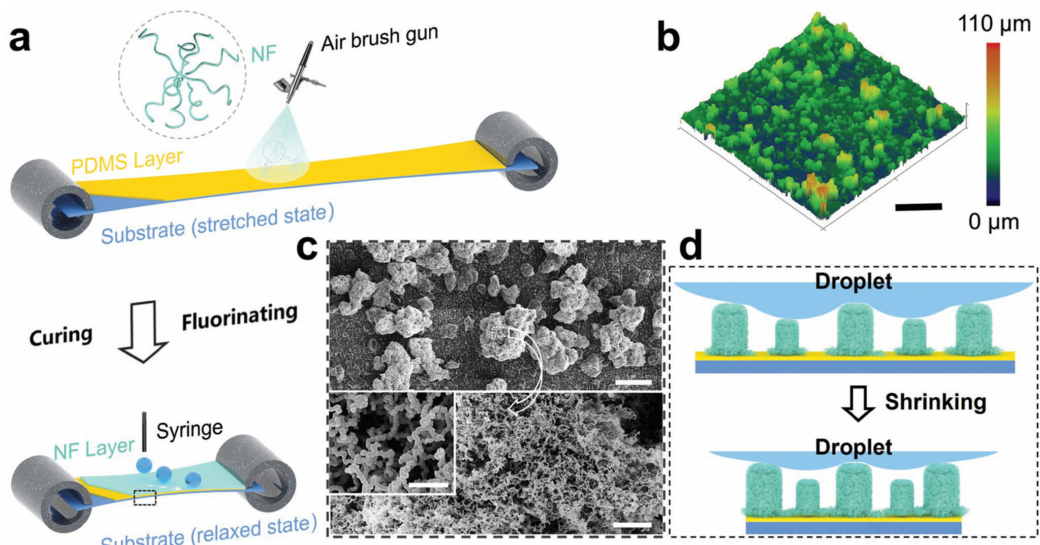
Figure 10. ( a ) Schematic illustration of the fabrication process of the nanofilament-structured and stretchable superamphiphobic (NFSS) surface; ( b ) confocal 3D images of the NFSS surface. Scale bar = 200 µ m; ( c ) SEM images of the NFSS surface at various magnifications. Scale bar = 50 µ m ( top ), 2 µ m ( bottom ), and 500 nm (inset); and ( d ) schematic illustration of microstructures on the NFSS after releasing the surface from the stretched state (Reproduced from [48] with permission from John Wiley and